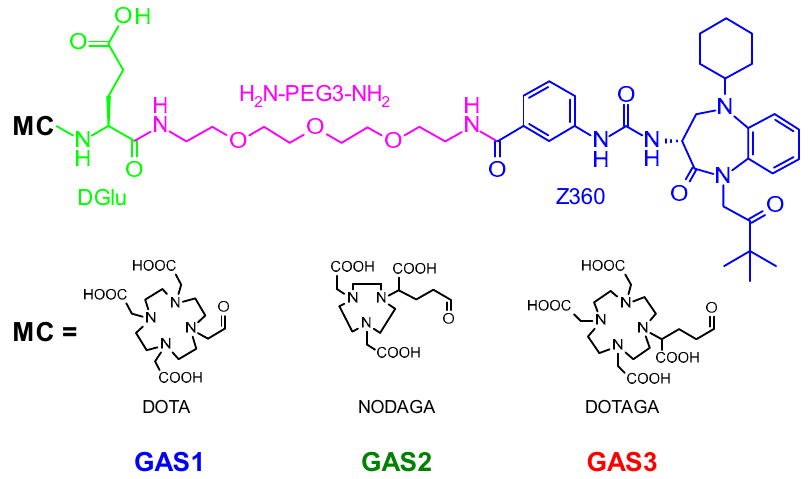
Figure 1. Chemical structure of GAS1, GAS2 and GAS3.